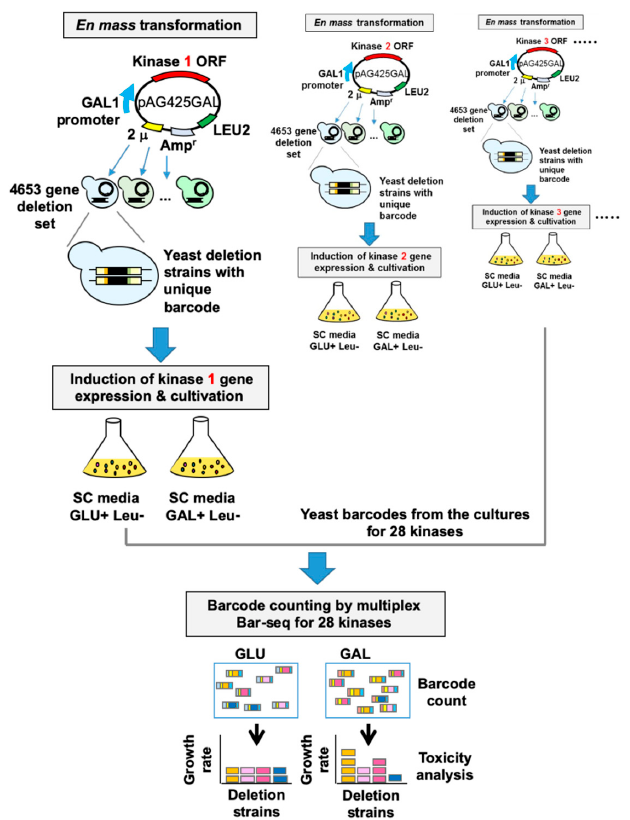
Figure 2. Flowchart of the yeast genetic interaction screen. The 28 toxic kinase genes were transformed individually into a pool of 4653 yeast homozygous deletion strains containing a 20-bp DNA barcode sequence. Transformants were selected in SD-Leu medium and then were resuspended in SGal-Leu medium and incubated for 2 days to induce the expression of kinase genes under the control of the GAL1 promoter. Genomic DNA was separately isolated from cells harvested after pooled culture in the presence of GLU or GAL. Barcodes were amplified from genomic DNA with multiplexed primers containing distinct combinations of two different tags for each kinase gene. Equal amounts of DNA amplified for each kinase gene were pooled and subjected to multiplex barcode sequencing using an Illumina Genome Analyzer. Next-generation sequencing data were then analyzed for barcode counting, which was used to screen kinase–yeast genetic interactions. For each of 4,653 yeast deletions, we identified the relative abundance of each deletion strain